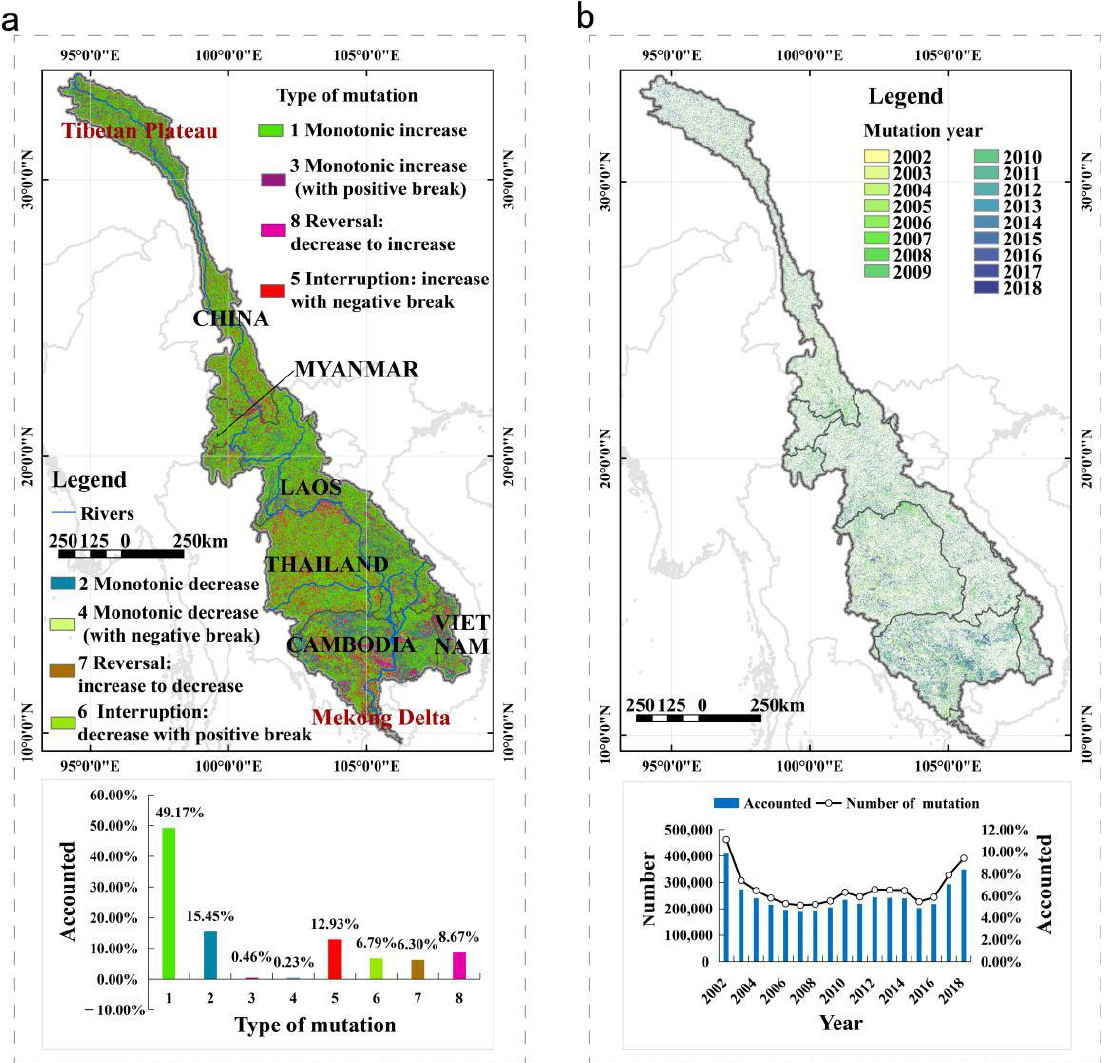
Figure 7. Mutation type ( a ) and mutation year ( b ) of BFAST01. The numbers 1,2,3,4,5,6,7,8 in Figure ( a ) represent the corresponding mutation type.